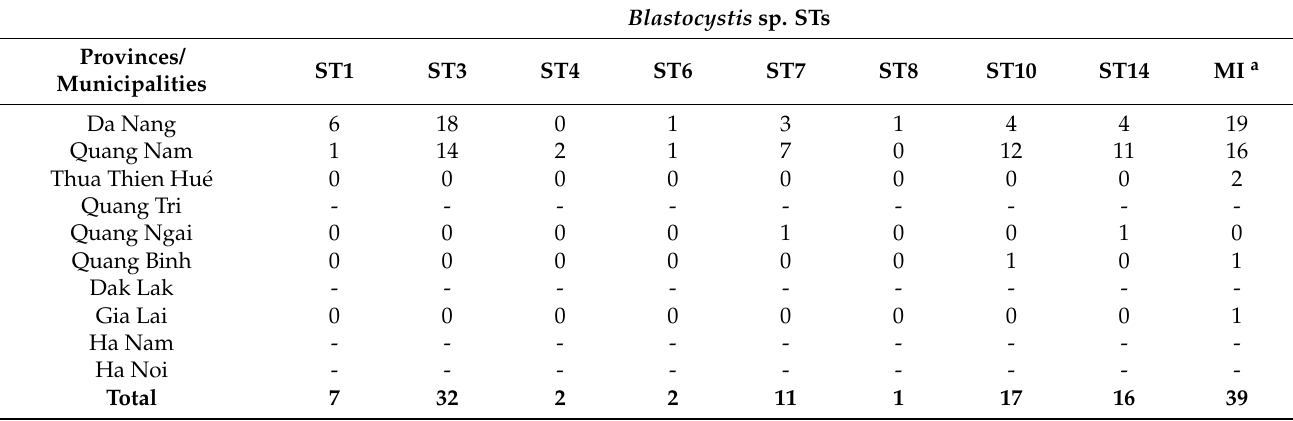
Table 2. Distribution of Blastocystis sp. STs in the Vietnamese cohort after considering subtyped isolates present in mixed